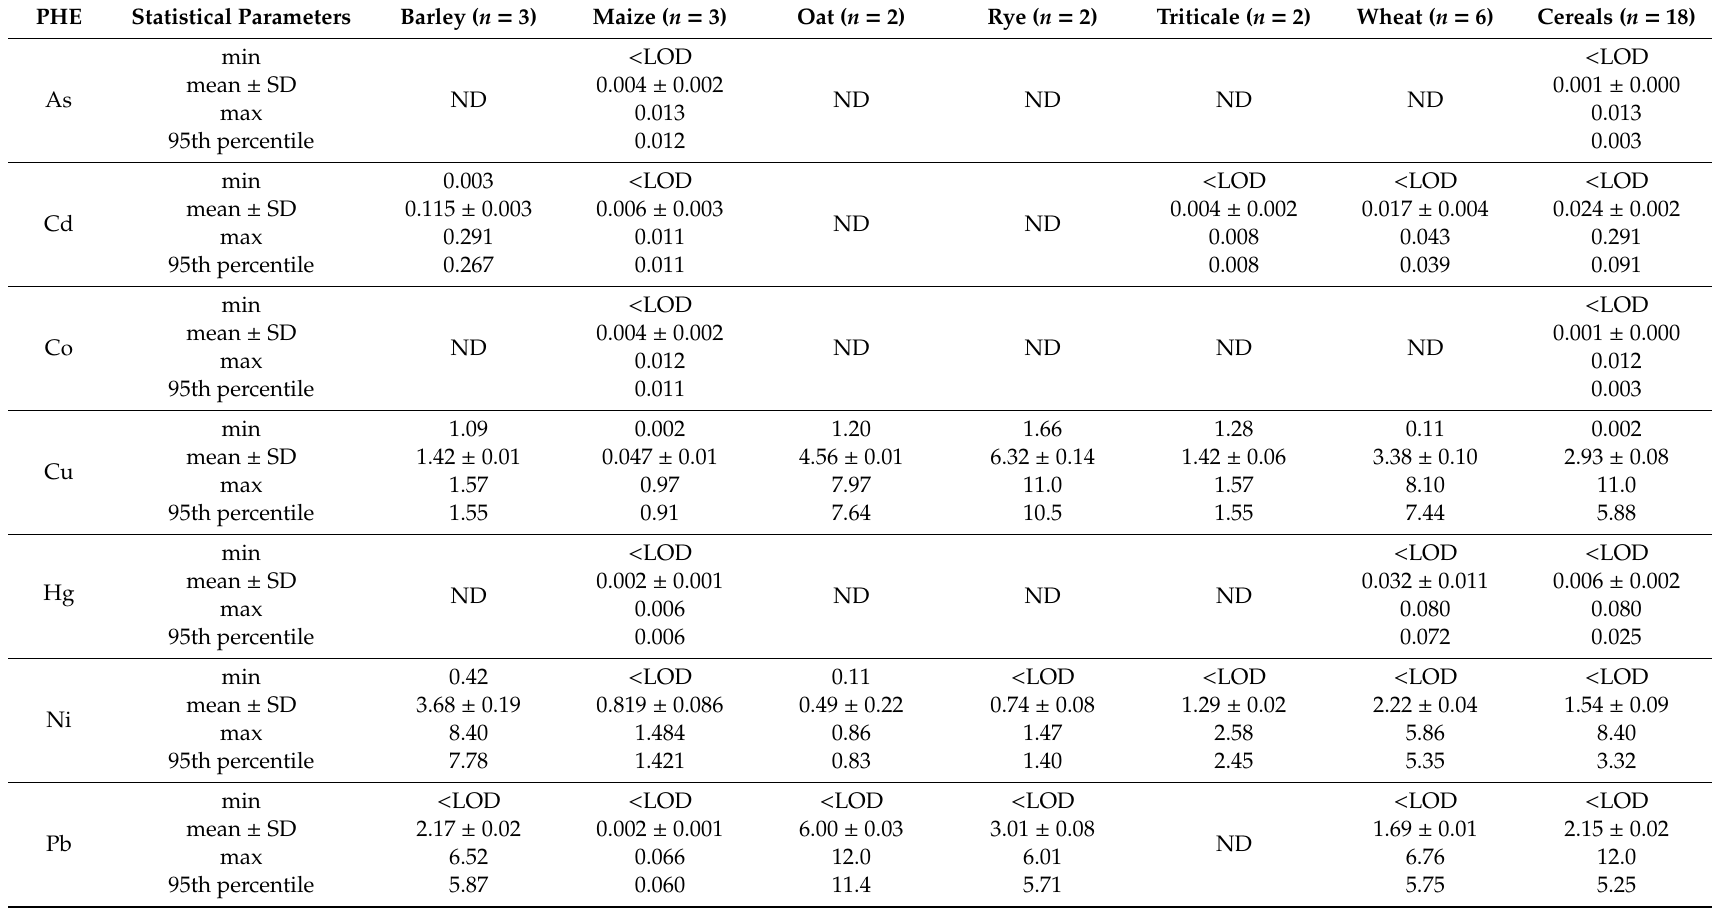
Table 3. Statistical parameters of potentially harmful elements (PHEs) in